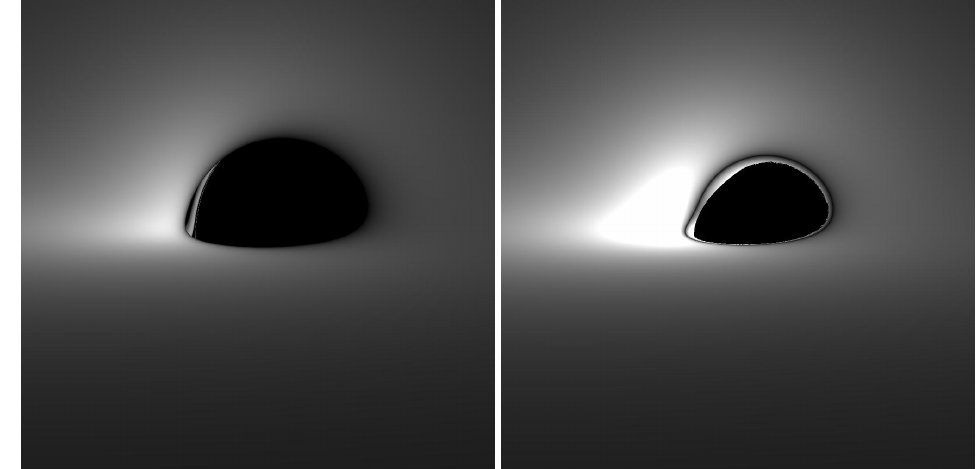
Figure 3. Infinite, counter clockwise rotating geometrically thin accretion disc around a rotating compact object, viewed from an inclination of 80 ◦ . The disc model by [49] was used. The right panel is a simulation within pc-GR for a = 0 and the right panel for a = 0.9 m 0 . Both figures are for n = 3. (Figures taken from [14,16,17].) The figures were obtained using the open accessible 2014 version of the GYOTO routines [48].